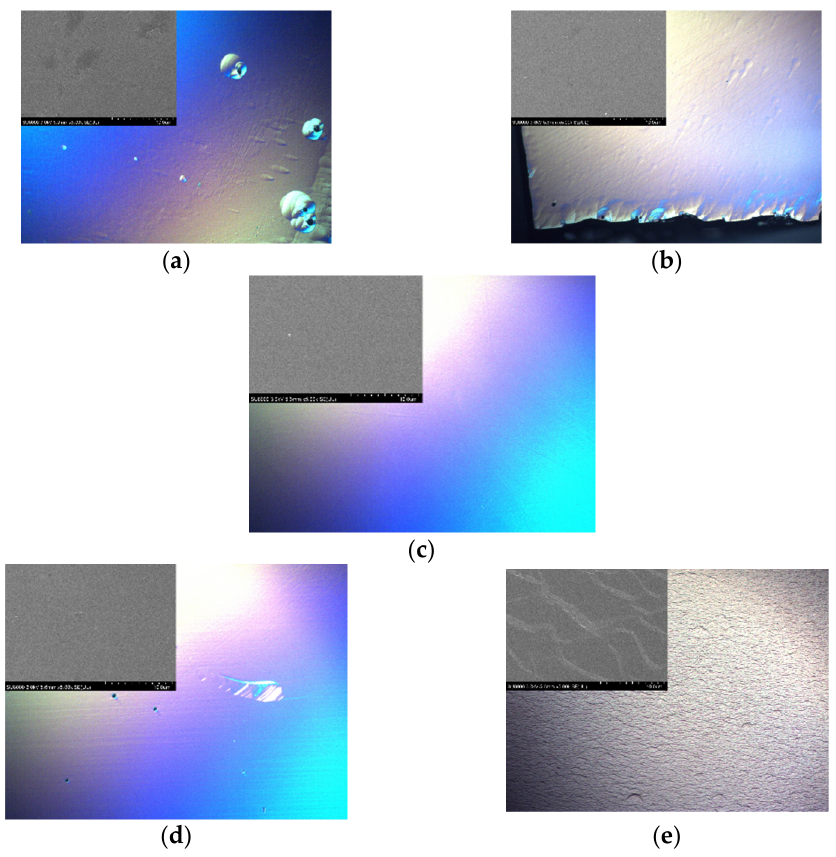
Figure 2. Surface images of the substrate with different concentration of CH 4 : ( a ) 6%; ( b ) 6.2%; ( c ) 6.4%; ( d ) 7%; ( e ) 8%.